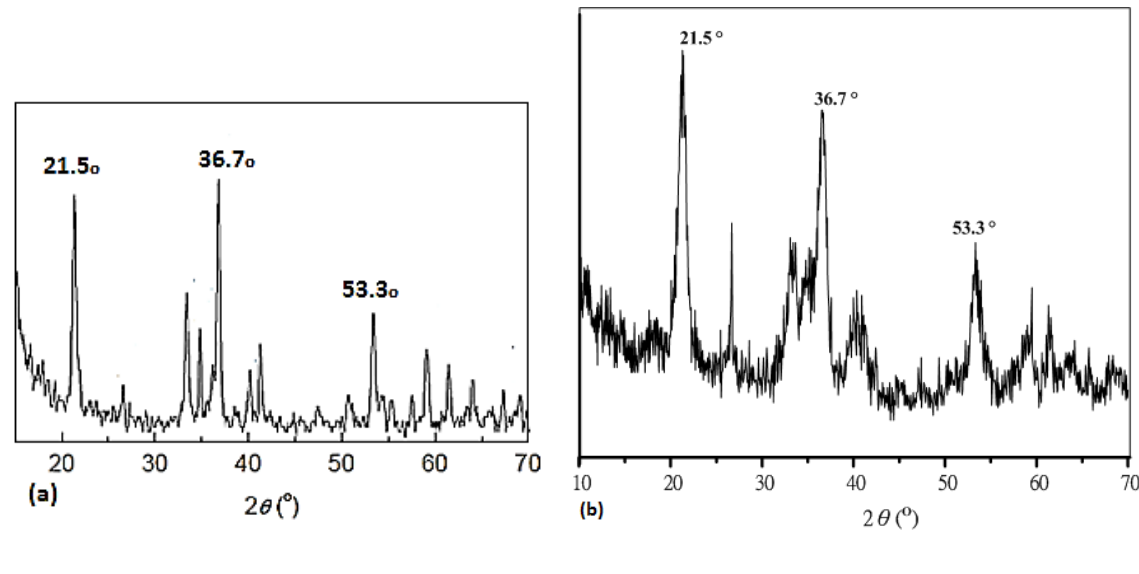
Figure 4. The effect of initial concentration of KMnO